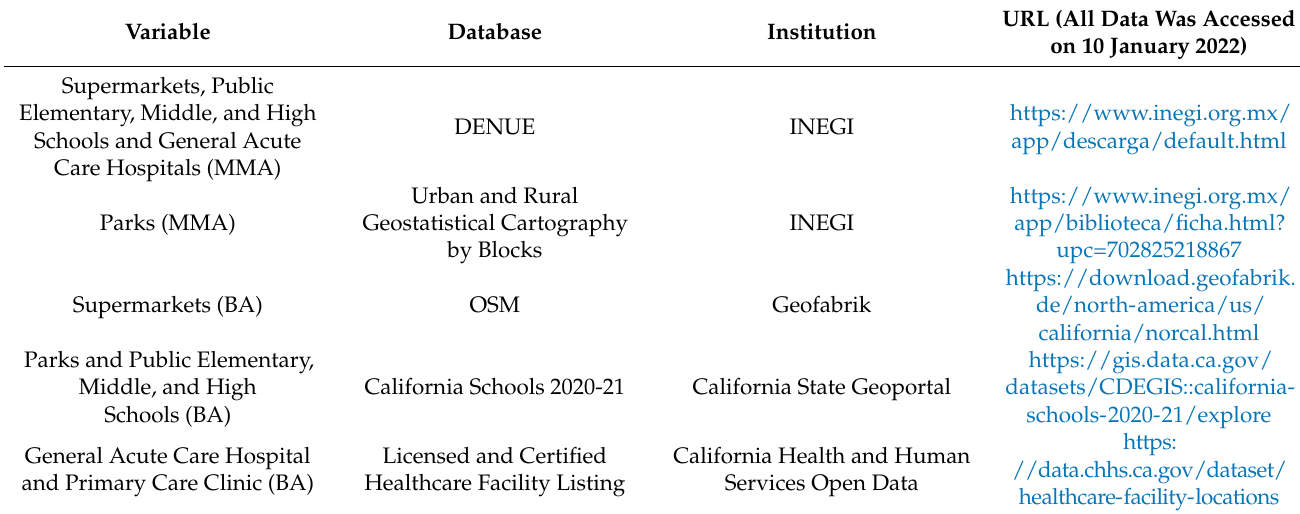
Table 4. Destinations’ datasets.